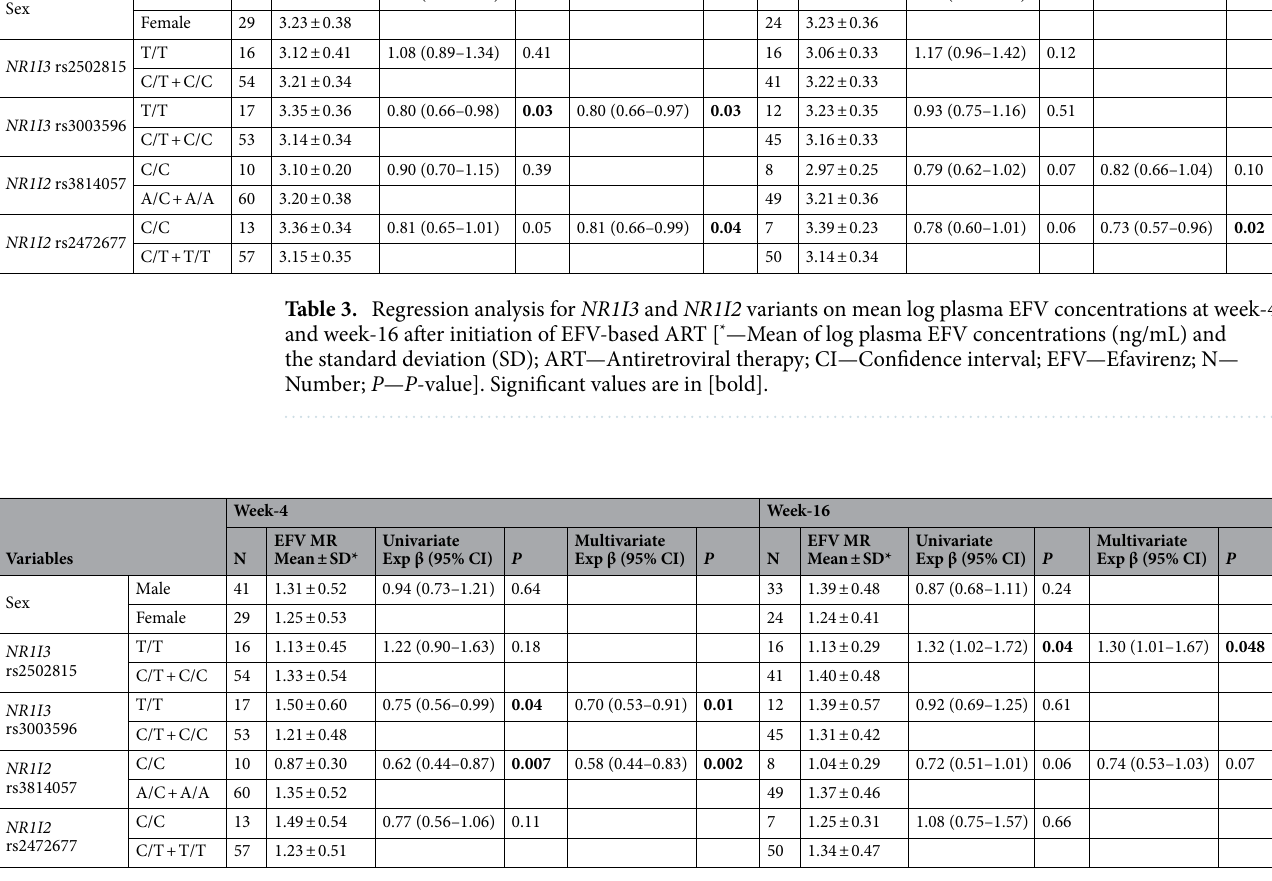
Table 4. Regression analysis for NR1I3 and NR1I2 variants on mean log plasma EFV/8-OH-EFV metabolic ratios (MRs) at week-4 and week-16 after initiation of EFV-based ART [ * —Mean of log plasma EFV Metabolic ratios and the standard deviation (SD); ART—Antiretroviral therapy; CI—Confidence interval; EFV— Efavirenz; MR—Metabolic ratio; N—Number; P — P value]. Significant values are in [bold].